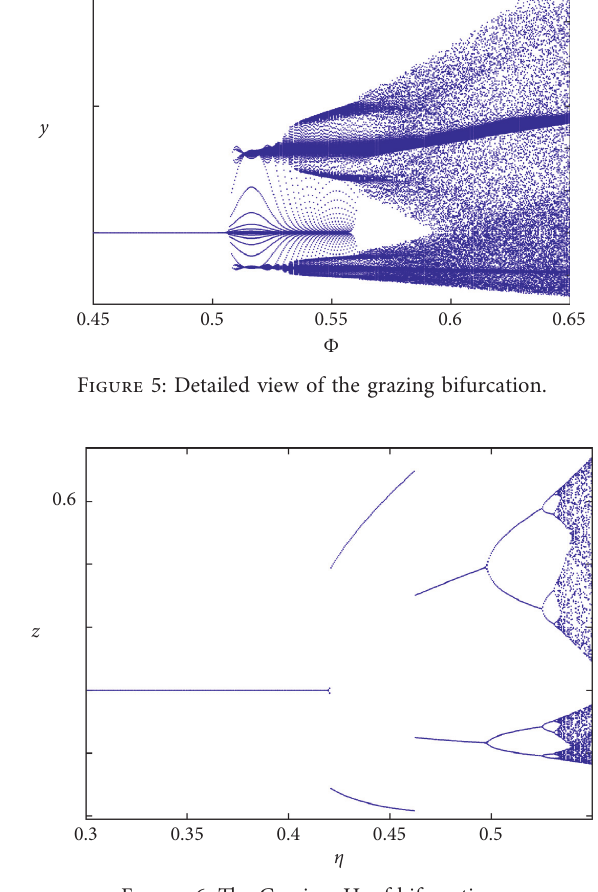
Figure 6: The Grazing–Hopf